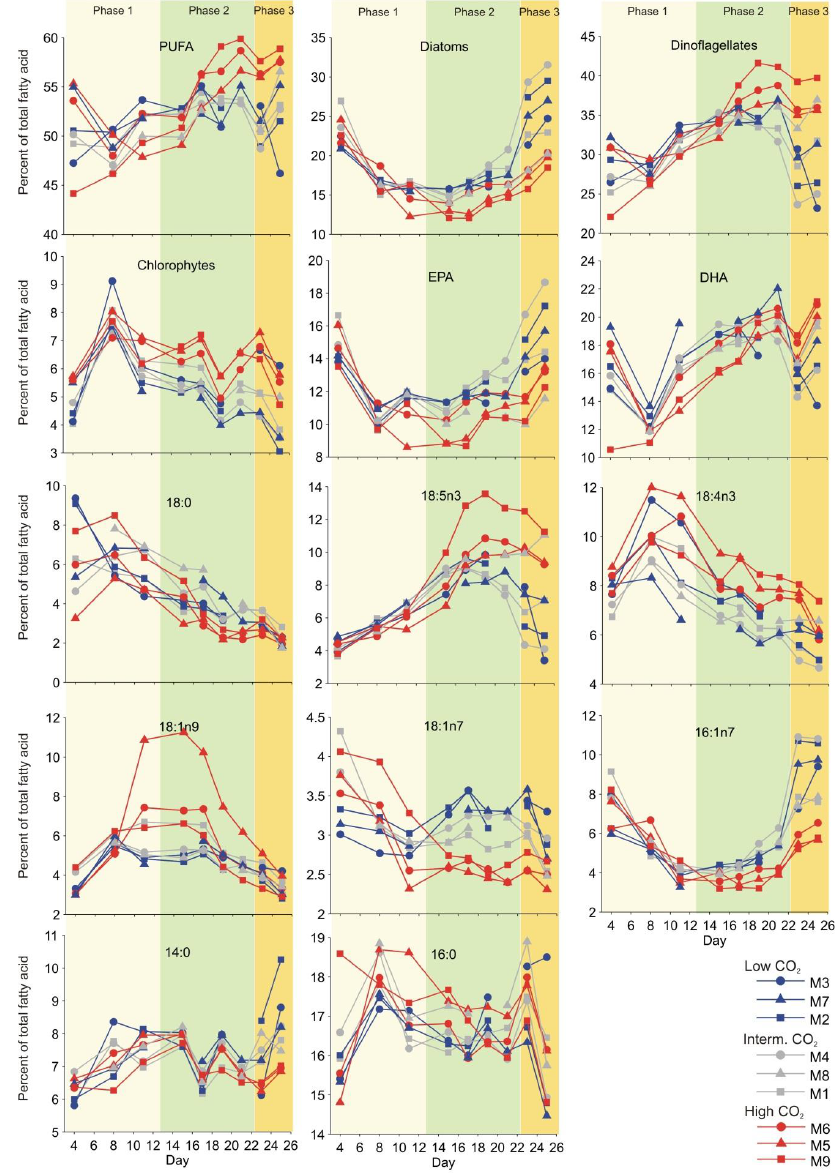
Figure 2 2 Fig. 2. Temporal development of selected fatty acids (in % of total fatty acids) during the experiment. Colour coding and experimental phases as in Fig.